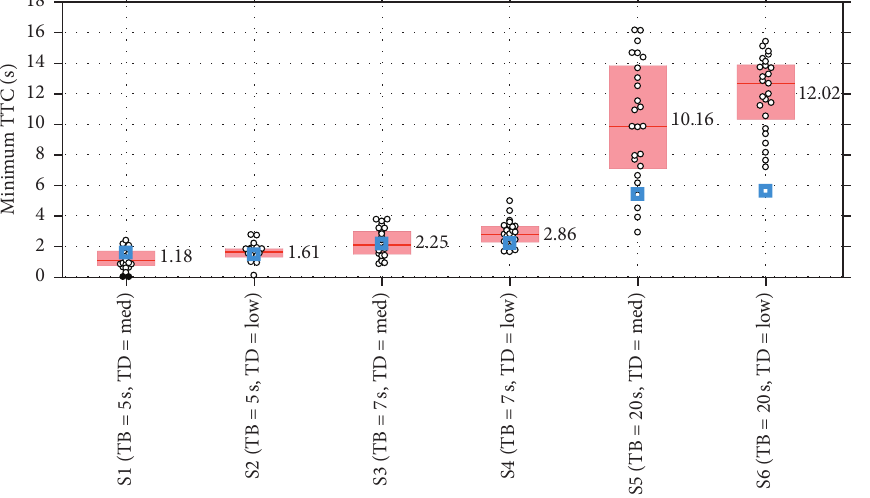
Figure 6: Boxplots of the minimum time to collision (MTTC) for the six scenarios. White circles represent noncollision trials (MTTC > 0 s); black circles represent collision trials (MTTC � 0s). The blue markers represent the values of the trajectory planner. Boxes capture the 25 th to 75 th percentiles, and the red line marks the median. The numbers next to each box represent the means of participants. Table 3: Results of repeated-measures ANOVAs for the dependent